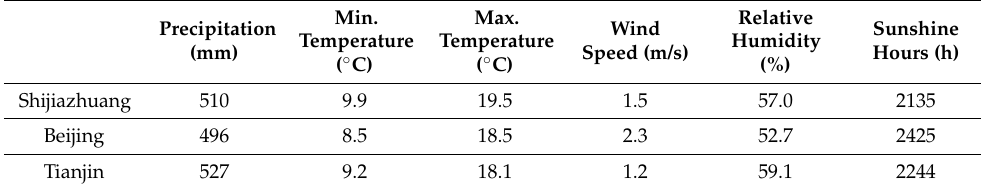
Table 3. The average weather data in the study